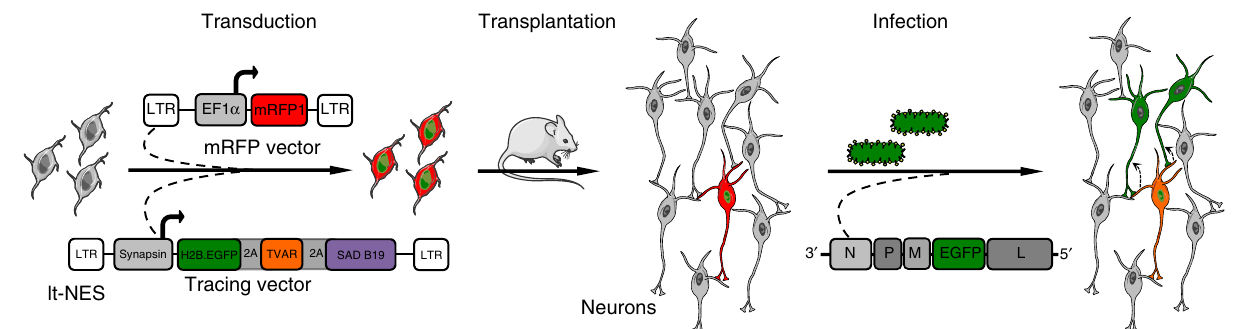
Figure 1 | Experimental procedure for tracing host-graft connectivity. Lt-NES cells were transduced with two lentiviral vectors expressing mRFP1, and an H2B.EGFP fusion protein coupled via 2A peptides to the TVA receptor and the RABV B19 glycoprotein. Ten weeks after transplantation the grafts were infected with RABV D G-EGFP(EnvA), which enables monosynaptic retrograde tracing of afferent host neurons. Parts of the schematic were produced